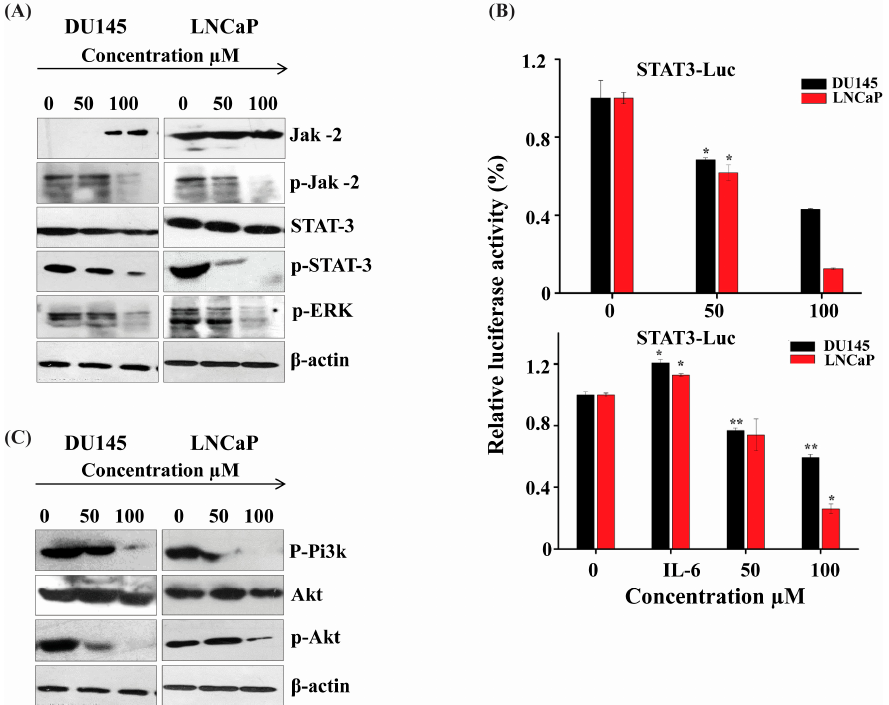
Figure 4. ATR II induces apoptosis in prostate cancer through JAK2/STAT3 signaling pathways. ( A ) DU145 and LNCaP cells were pre-incubated with ATR II at different concentrations (0, 50 and 100 µM) for 48 h, then the protein expression of JAK2, STAT3, and ERK was detected by immunoblotting. ( B ) ATR II inhibits constitutive STAT3 and IL-6 in DU145 and LNCaP cells line: cells were